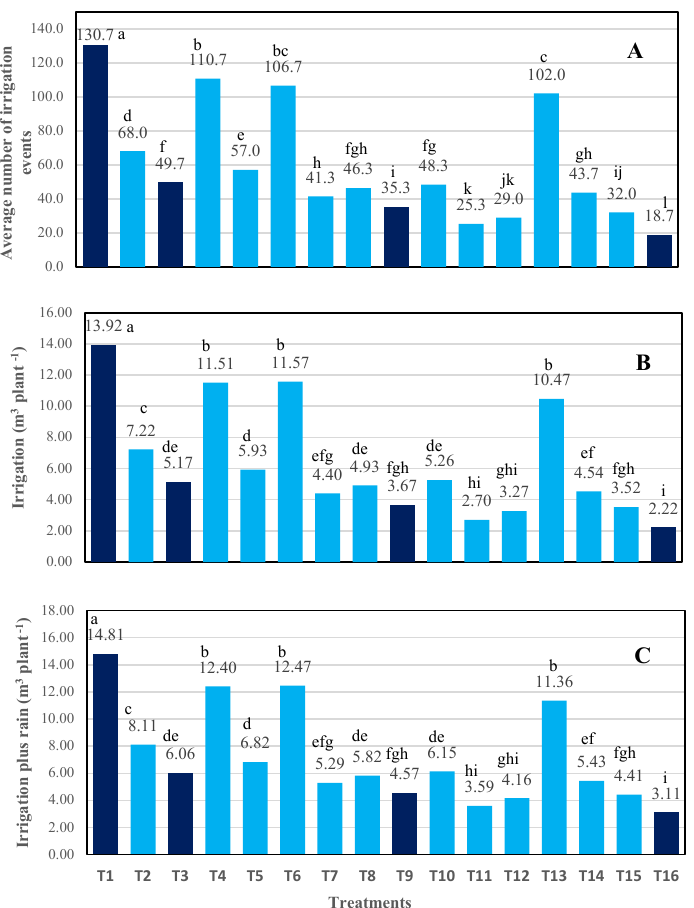
Figure 2. Average number of irrigation events per treatment ( A ), volume of irrigation applied per plant ( B ), and total water application per plant (irrigation plus rain) ( C ). Dark blue bars correspond to treatments with the same soil moisture tension during the two phenological stages. Different letters on the bars mean statistical differences (Tukey, p ≤ 0.05). T1 to T16 are soil moisture tension treatments (kPa).